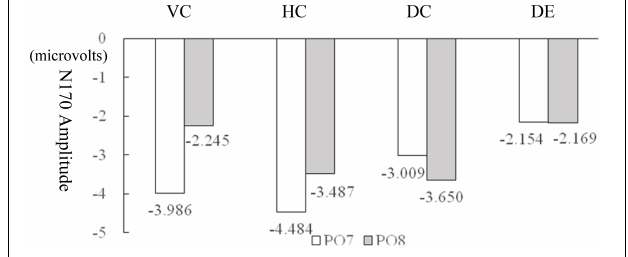
TABLE 4 | Summary table of behavioral and EEG